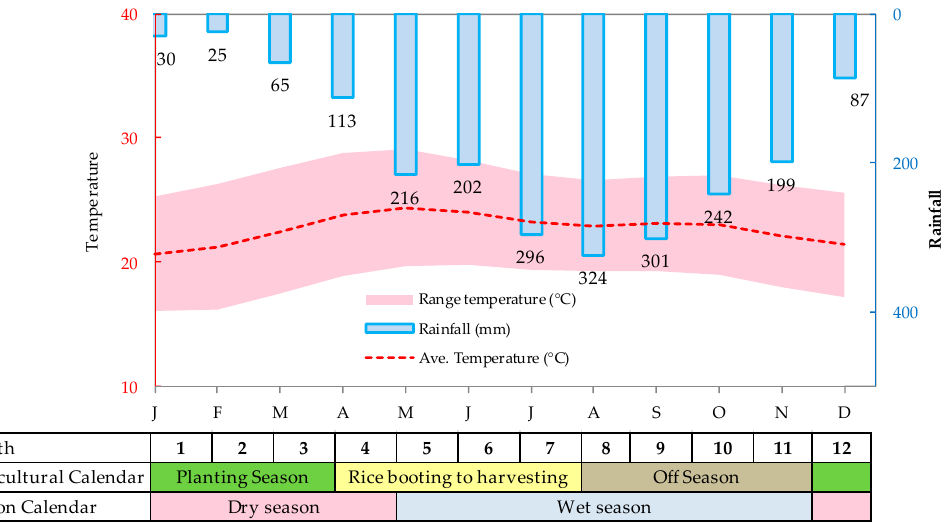
Figure 3. Maximum and minimum temperature in Kiangan, Ifugao and agricultural calendar (climate data were collected from the Philippines climate data).